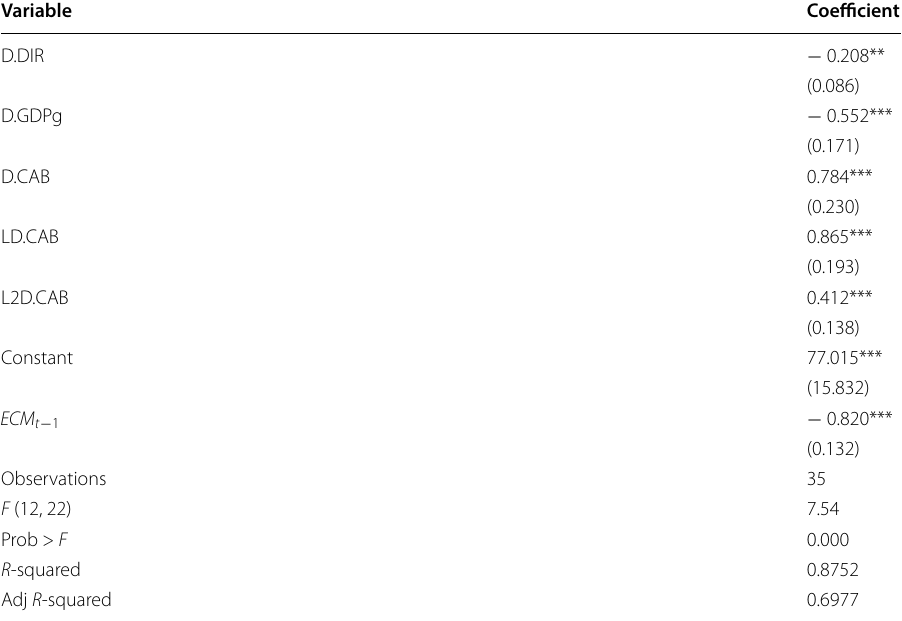
World Development Indicators database for